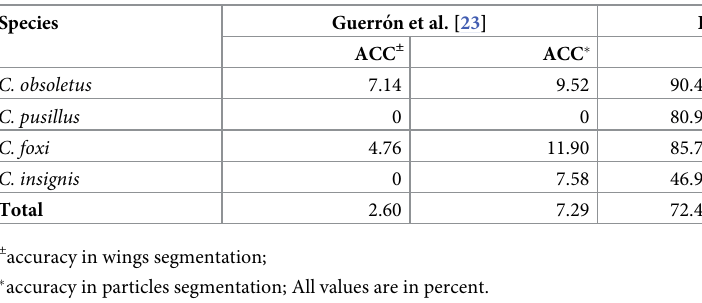
C. obsoletus and 95% for C. pusillus ), while the species from the eDataset obtained lower values (81% for C. foxi and 85% for C. insignis ). These results were expected, considering the results